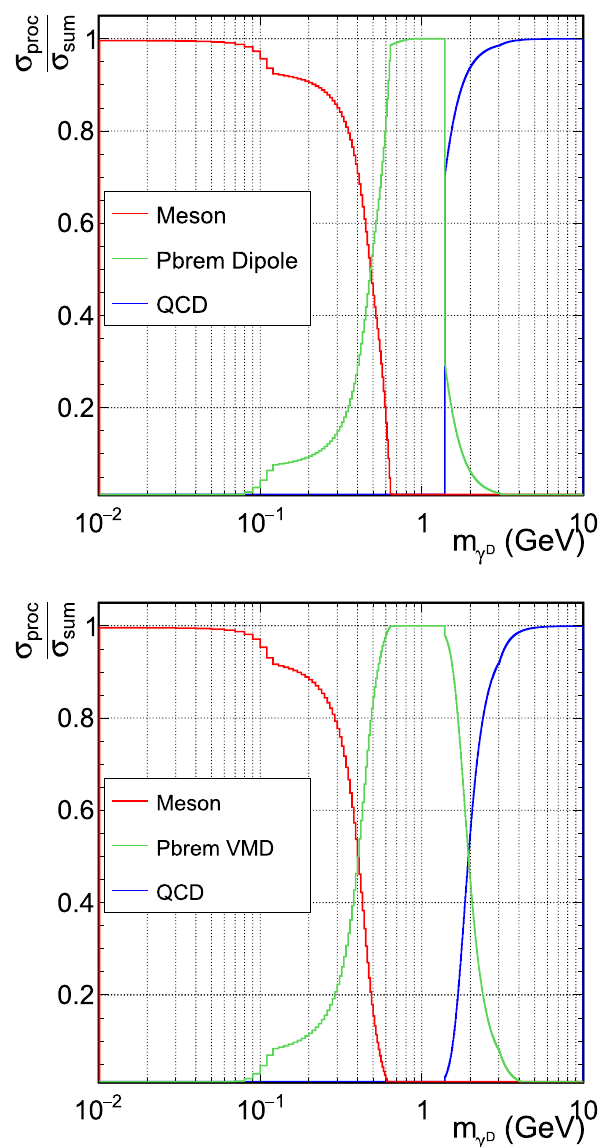
Fig. 6 Relative contributions to the cross section as a function of m γ D for the three production modes studied, using the dipole form factor for proton bremsstrahlung (top) or the VMD form factor (bottom)